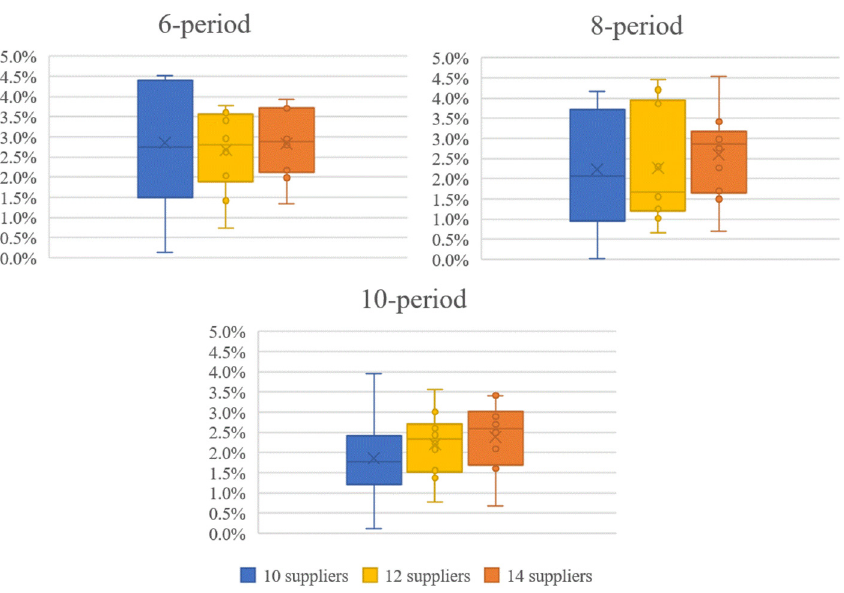
Figure 1. Summary of PE (%) of tests (6, 8, and 10-periods).